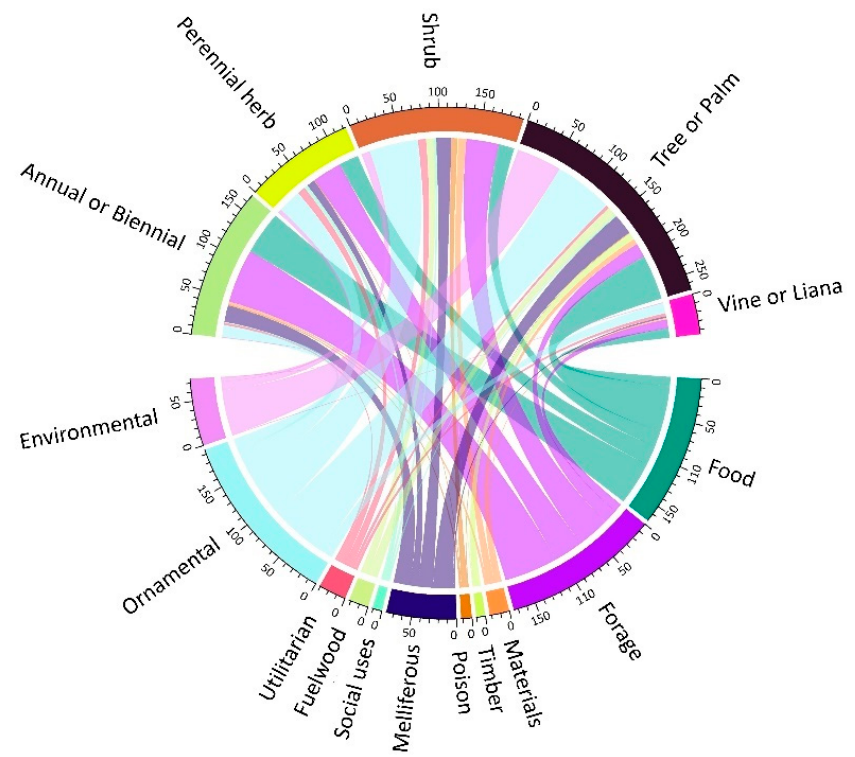
Figure 4. The chord diagram shows the relation between the uses and the habit of the taxa. The areas are proportional to the number of taxa.